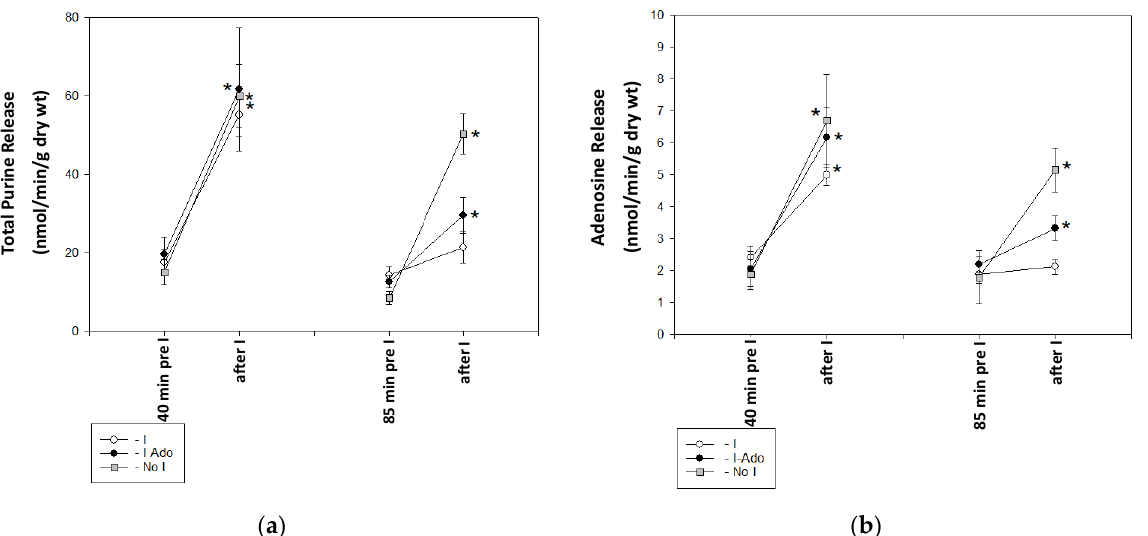
Figure 1. Release of ( a ) purine catabolites (sum of adenosine + inosine + hypoxanthine + xanthine +